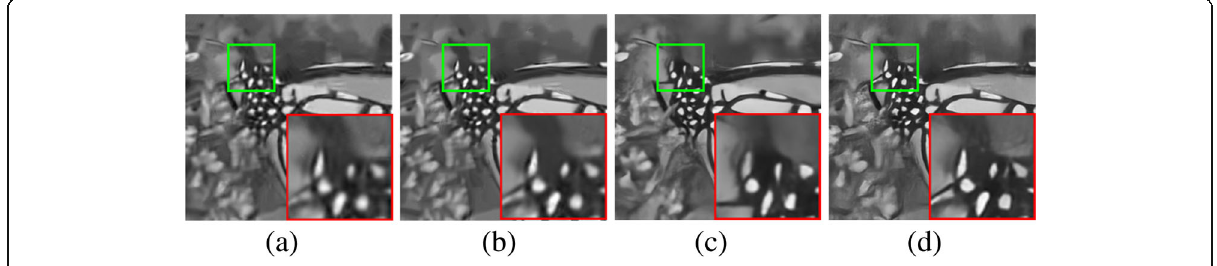
Fig. 4 Visual comparisons of denoising results on Monarch image corrupted by additive white Gaussian noise with standard deviation 75: a BM3D [55] (PSNR = 23.91 dB); b WNNM [58] (PSNR = 24.31 dB); c DnCNN [106] (PSNR = 24.71 dB); d FFDNet [107] (PSNR = 24.99